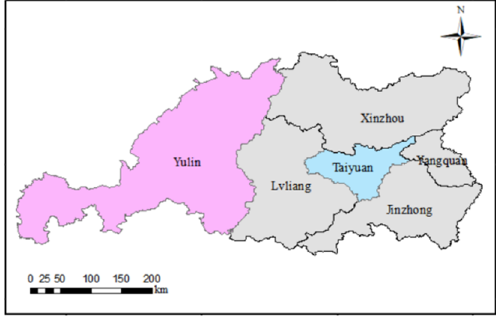
Figure 6. Location map of experimental area.